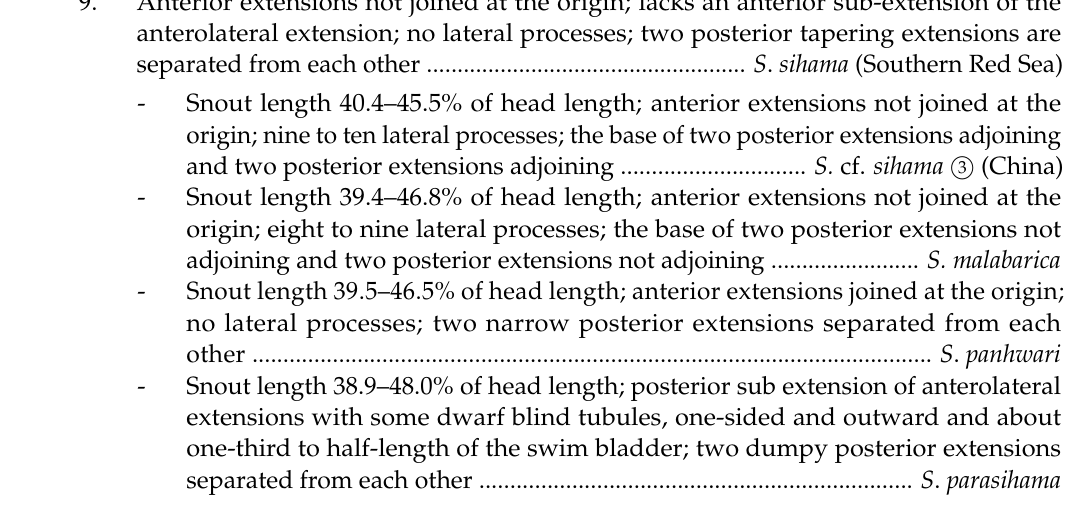
Table S1: Sampling information of two new Sillago species from the Bay of Bengal, Bangladesh; Table S2: Details of specimens used in genetic analysis with individual ID, sampling location, gene information, GenBank accession numbers, and references. Table S3. Net genetic distances (K2P) for COI gene sequences of the 42 Sillago species. Table S4. Net genetic distances (K2P) for 16S rRNA gene sequences of the 32 Sillago